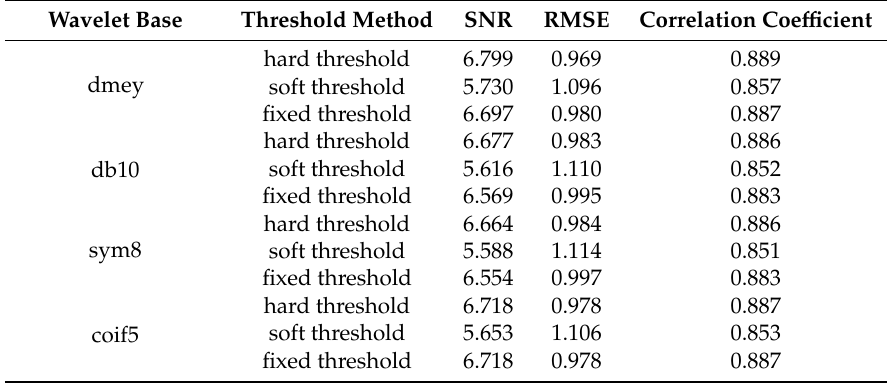
Table 4. SNR and RMSE of the four wavelet bases after noise reduction with three layers.